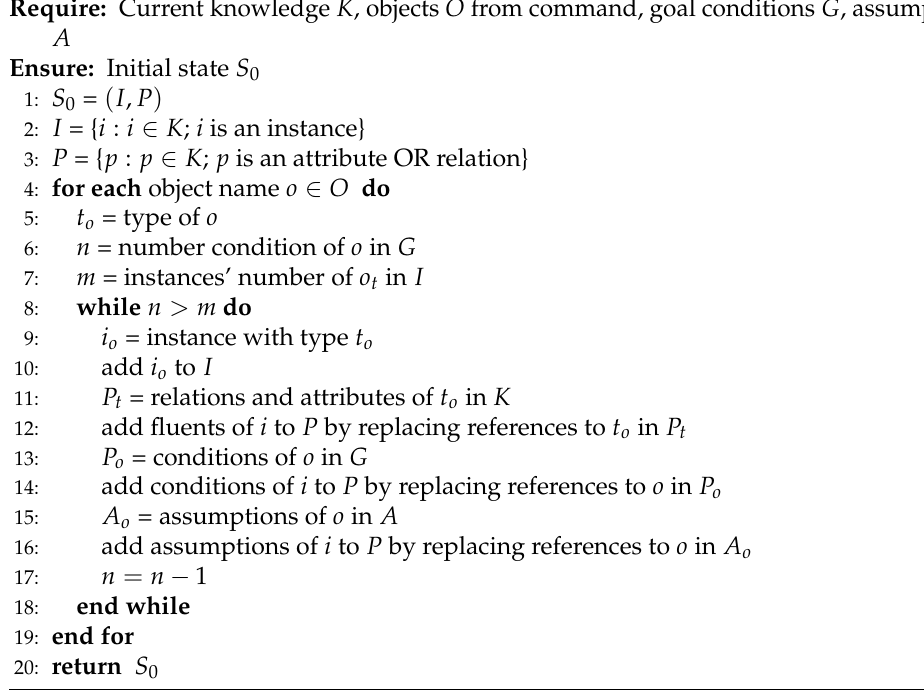
Algorithm 1 Initial State Construction with Assumptions